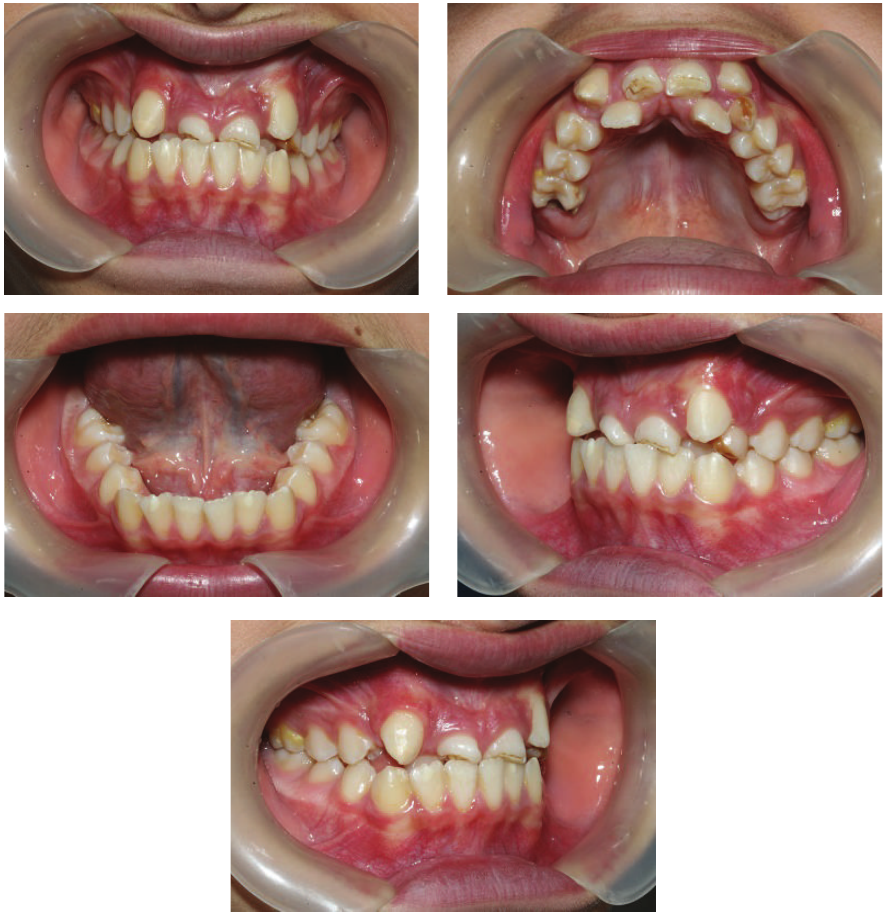
Figure 3: Pretreatment intraoral